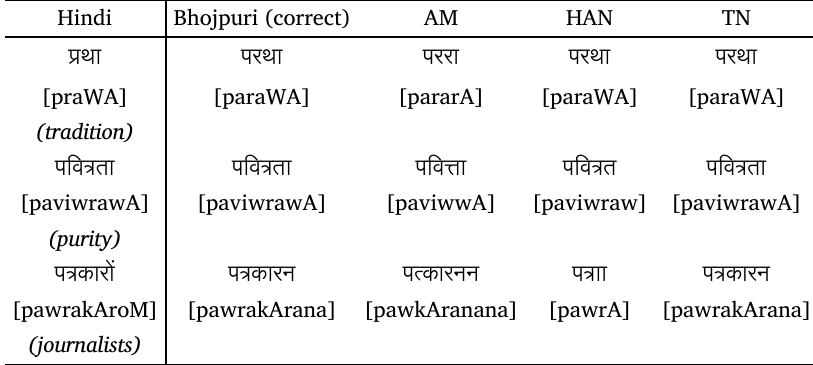
Table 6: Handling halant